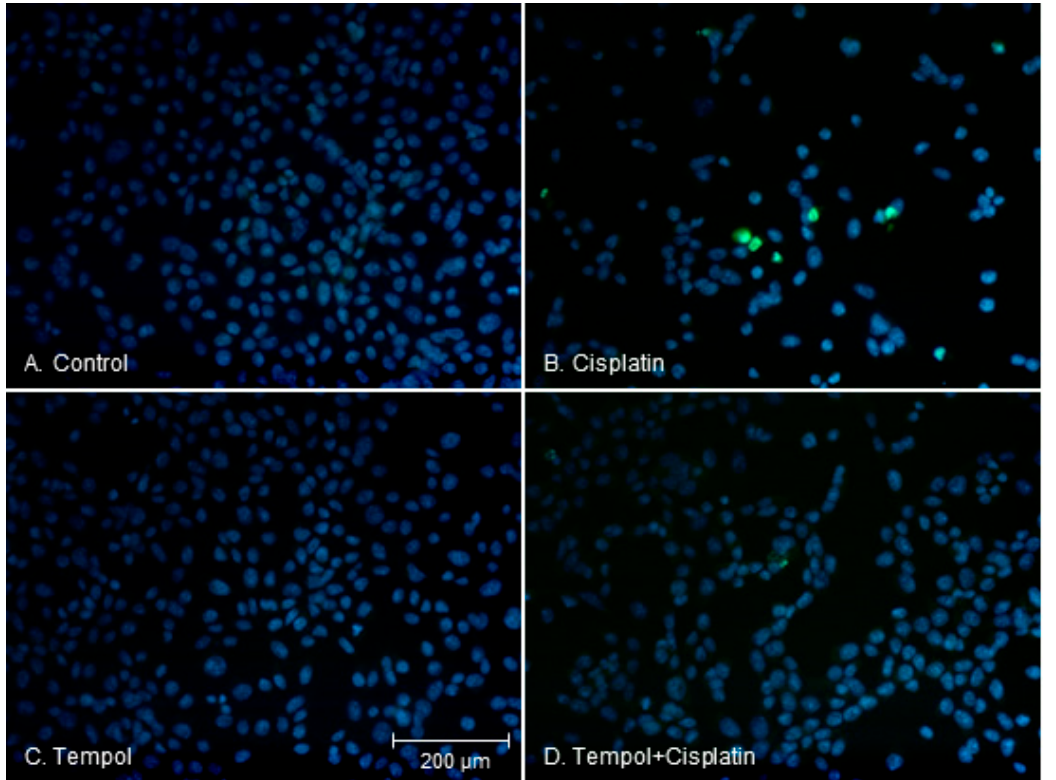
Figure 2. Apoptotic features in HEI-OC1 cells were decreased by pre-treatment with 50 μ M Tempol for 2 h before cisplatin exposure for 24 h. The control ( A ) and Tempol-treated cells ( C ) show round-shaped nuclei with homogeneous intensity; Cisplatin-exposed cells show fragmented nuclei and apoptotic properties (green fluorescence) ( B ); Fewer cells display these features in the